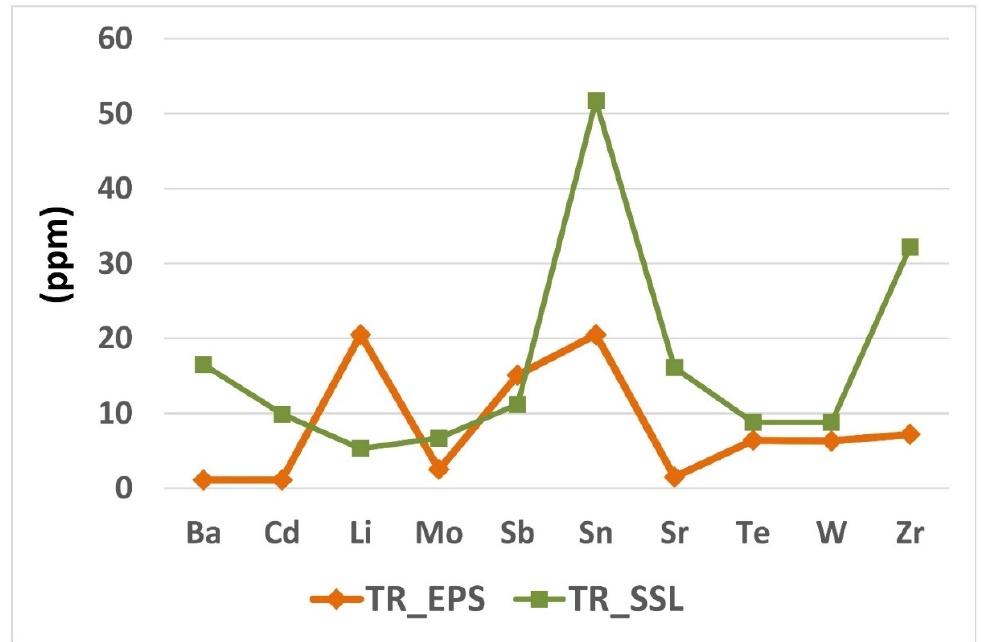
Figure 4. Trace elements concentration (ppm) in tremolite asbestos from Episcopia (TR_EPS) and San Severino Lucano (TR_SSL).